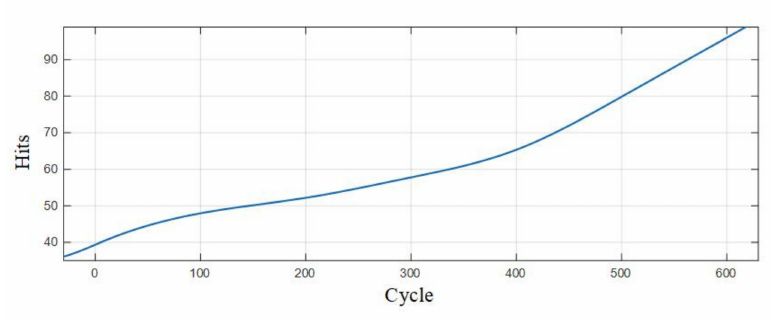
Figure 13. Cumulative curve of the number of pulse type acoustic emission